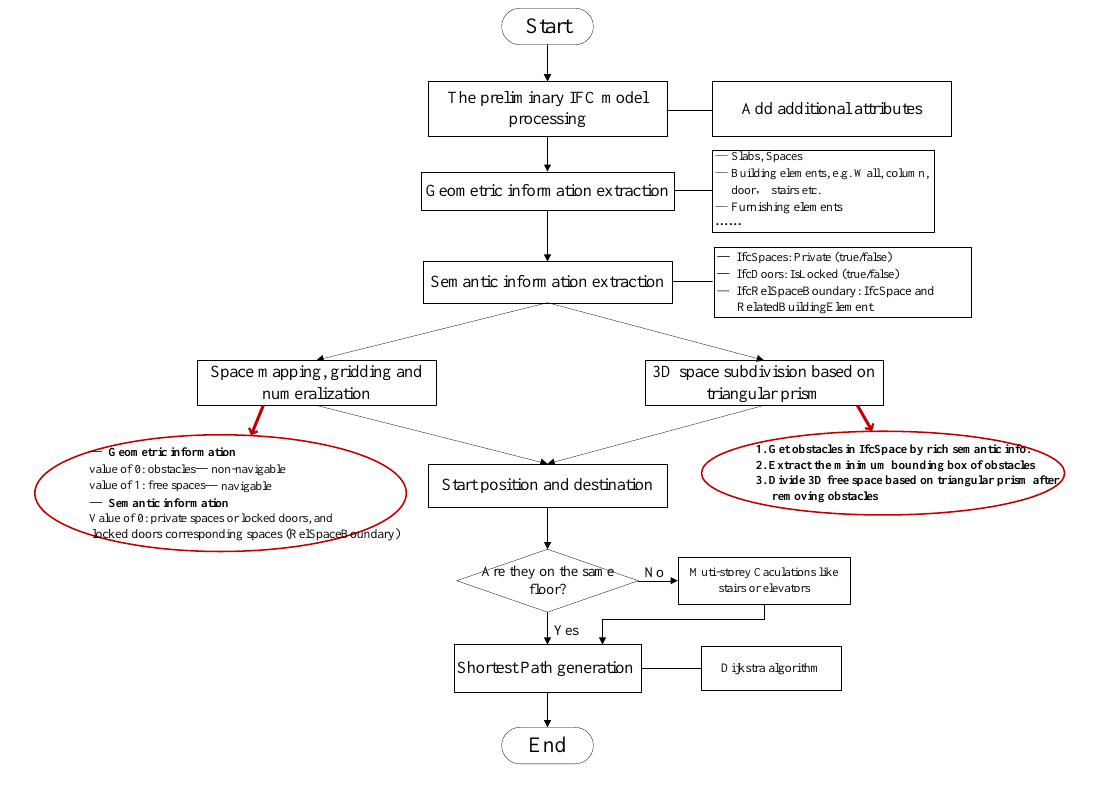
Figure 1. Technical workflow